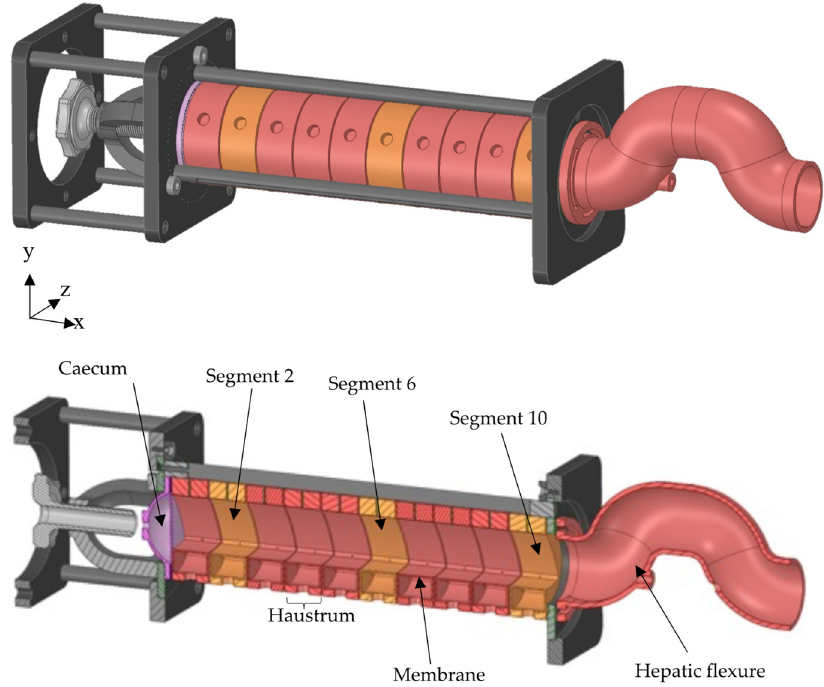
Figure 1. Schematic of the Dynamic Colon Model (DCM), Adapted from [12], MDPI, 2021. The DCM has a segmented appearance reflecting that of the human proximal colon: segment 1 is adjacent to the caecum , through to segment 10 adjacent to the hepatic flexure .